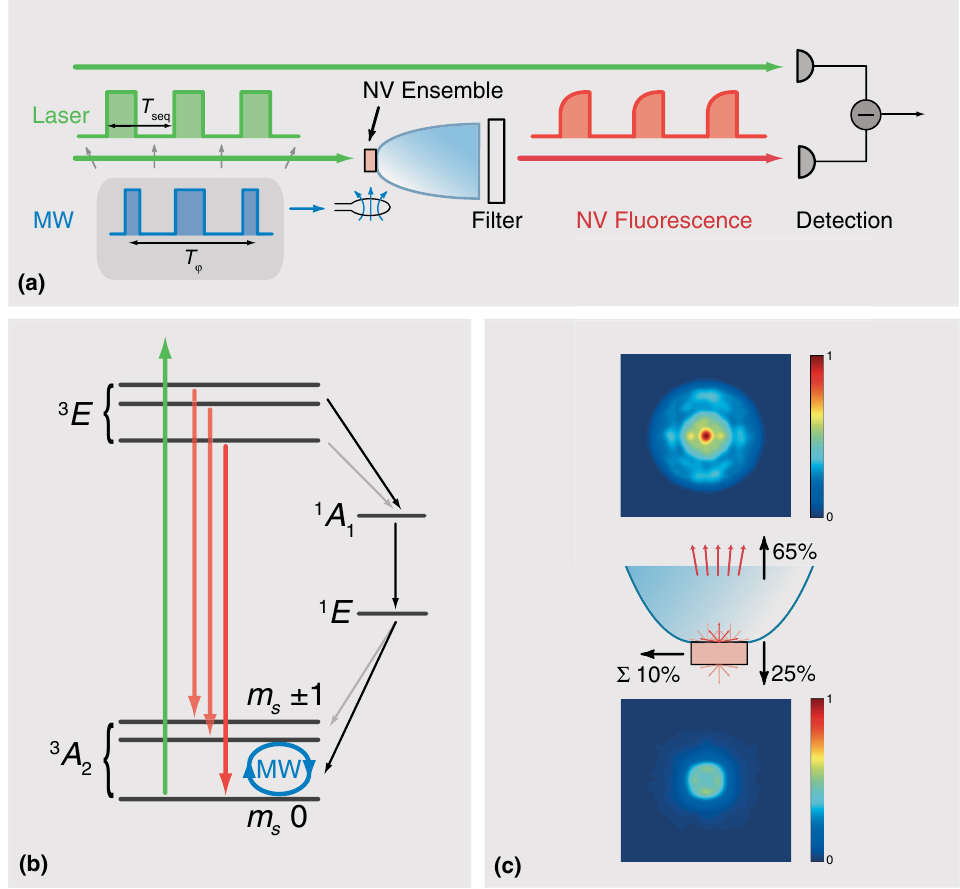
FIG. 1. NV diamond ensemble magnetometer. (a) Pulsed NVexperiment: NVensemble is excited by 532-nm laser pulses. Long-pass- filtered fluorescence is collected with part of the exciting light on a balanced detector. Microwave (MW) pulses are used for NV-spin manipulation. (b) NV-energy-level scheme: Manipulation of electron spin in a triplet ground state. Spin-state-dependent fluorescence allows readout of the spin state. (c) Fluorescence collection with parabolic collector (simulation